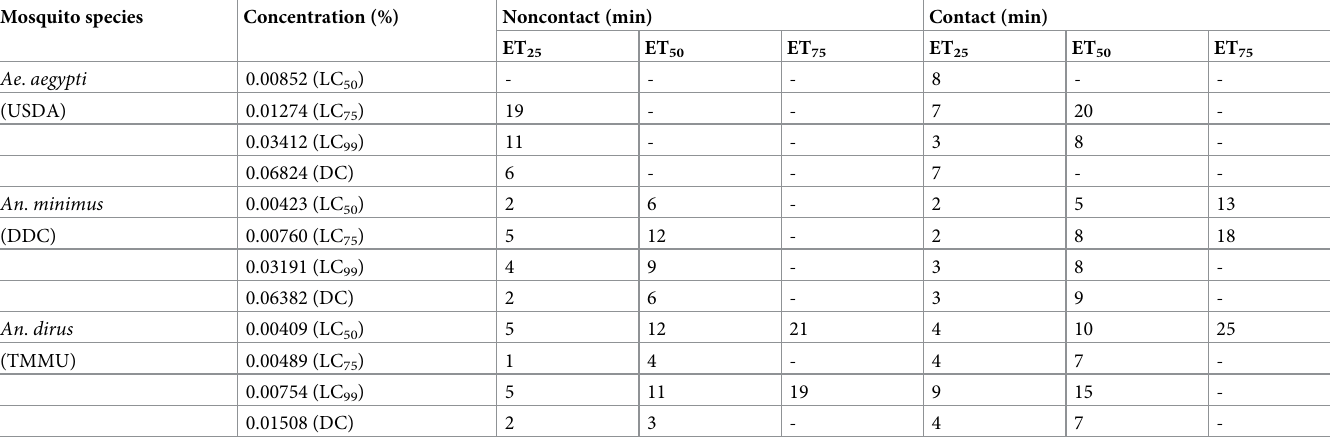
(-) Not applicable as too few mosquitoes escaped from chambers precluding escape time (ET) calculation. LC, lethal concentration; DC, discriminating